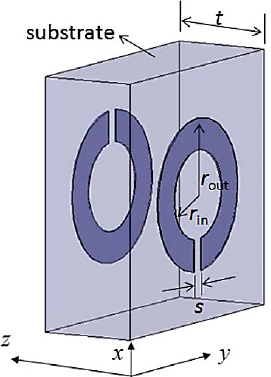
Figure 19. Geometry and dimensions of the SRR resonators. The inner and outer radii of the circular strips are r in = 0.7 mm and r out = 1.2 mm, respectively. The gap width of the circular strip is s = 0.2 mm. The thickness of the substrate is t = 1.524 mm (from [40]; copyright © IEEE 2014; reproduced with permission).